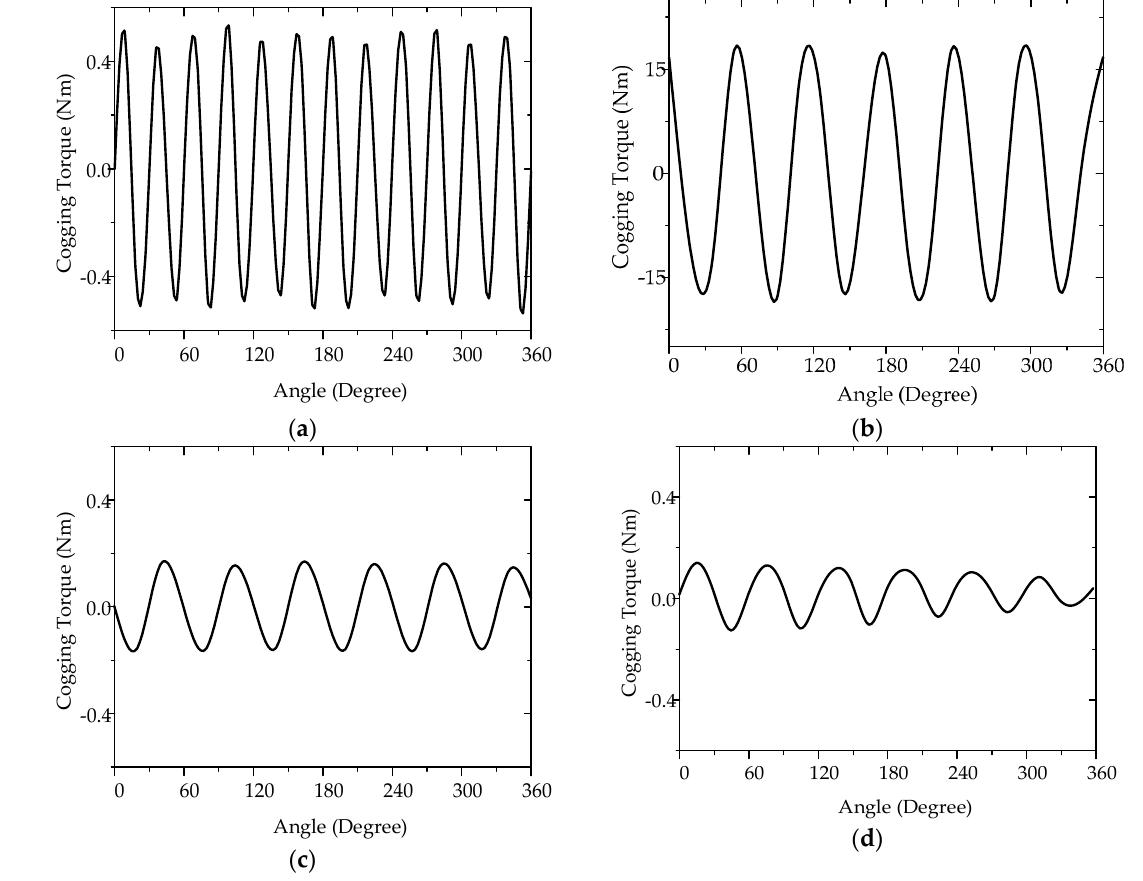
Figure 10. Cogging torque of proposed six-phase outer-rotor PM machines: ( a ) IPM type; ( b ) SPM type; ( c ) PMFS type; ( d ) PMV type. Table 3. Iron Loss of Proposed Six-phase Machines.